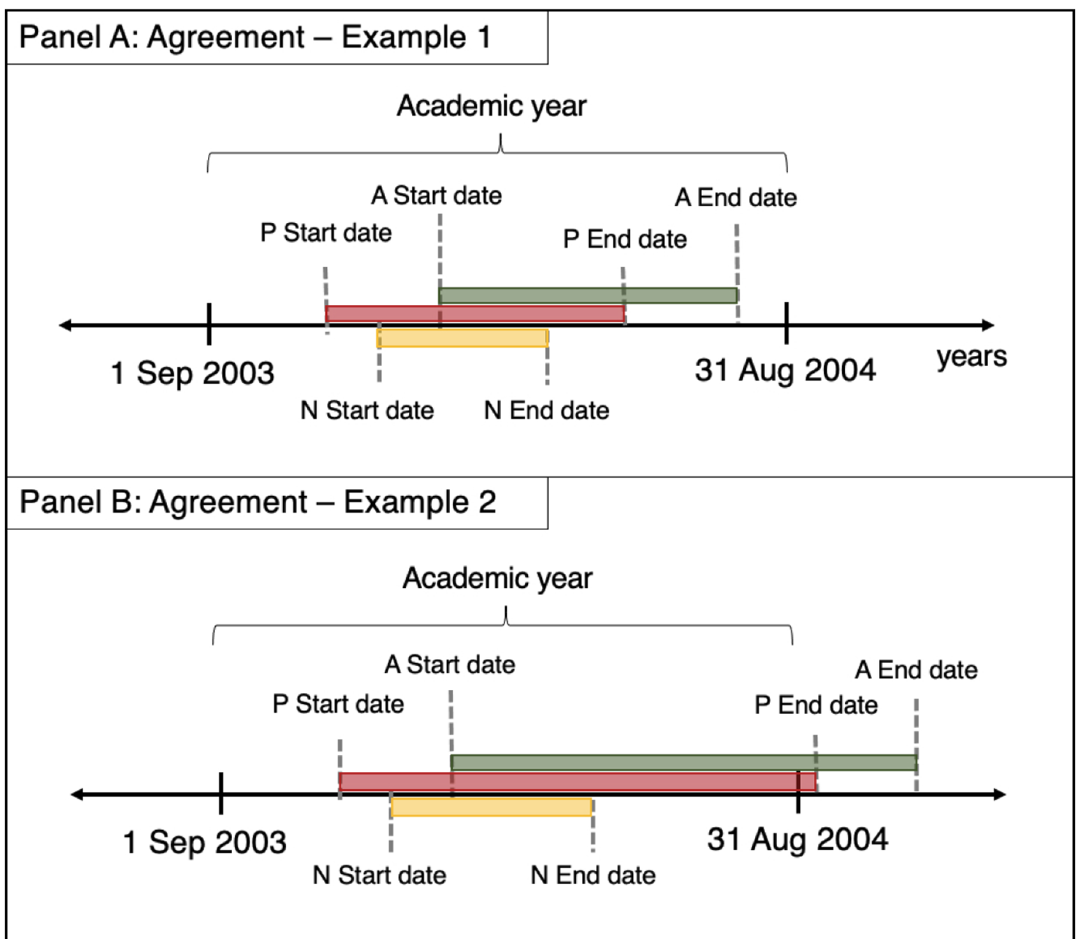
Supplementary Figure S2: Criteria for agreement dates, example using NPD spring census 2004 and three types of PDS